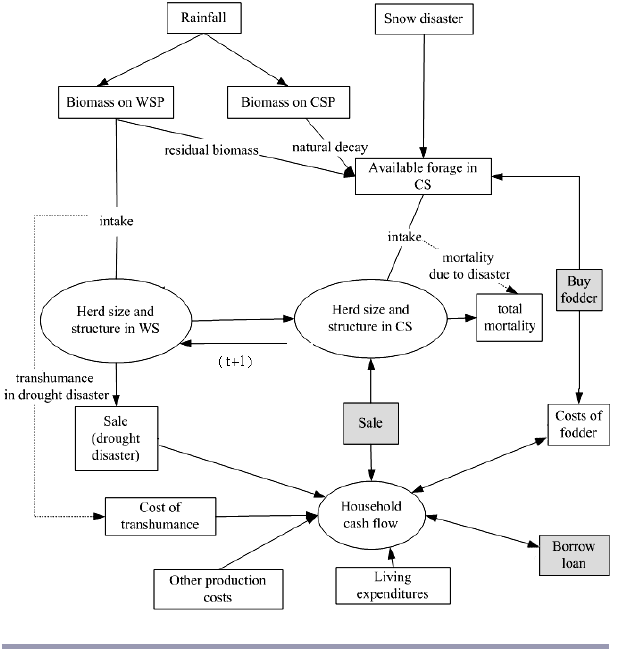
Table 2 . Set of state variables in the model.